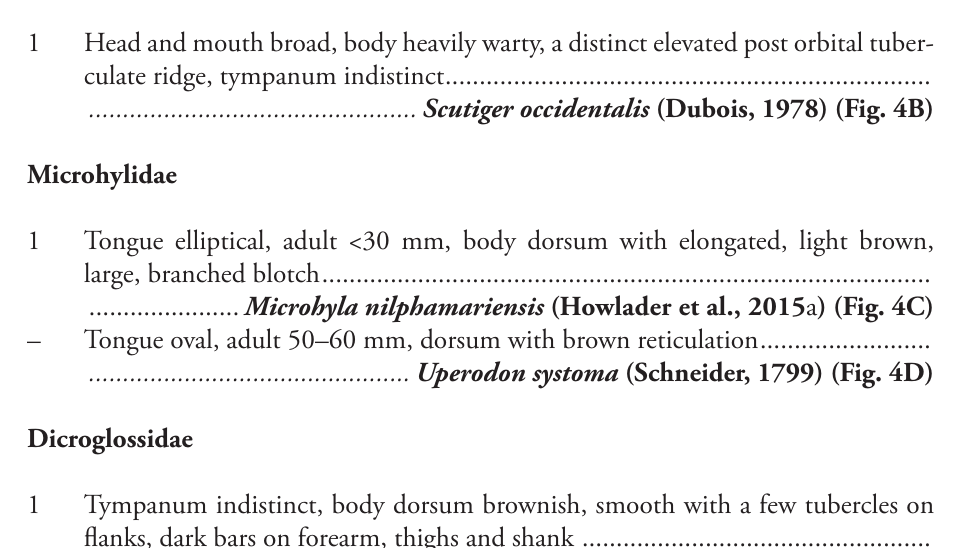
Tympanum indistinct, body dorsum brownish, smooth with a few tubercles